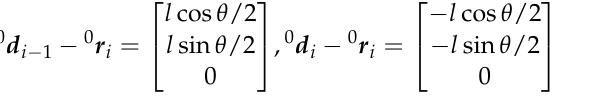
Figure 4. A link (i) and its vectorial kinematic characteristics. According to [35], the Newton – Euler equations of motion for link (i) in the global coordinate frame are